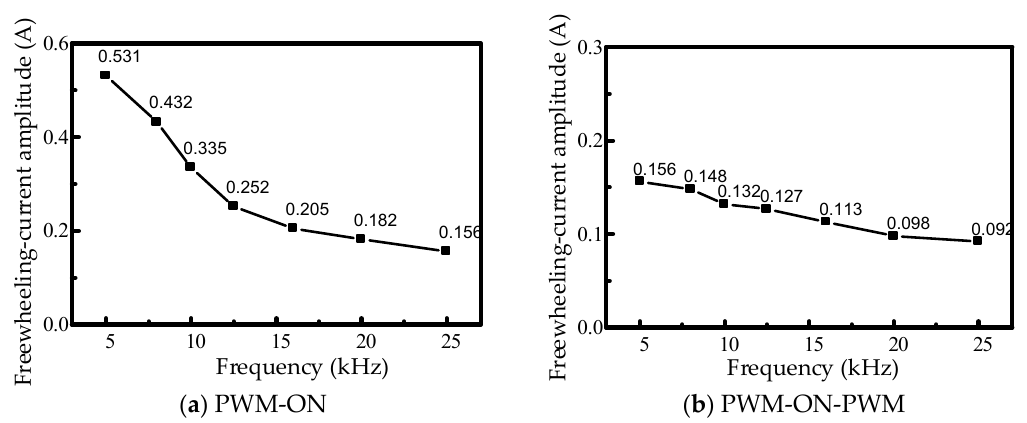
Figure 18. Relationship between freewheeling-current amplitude of non-conduction phase and frequency.